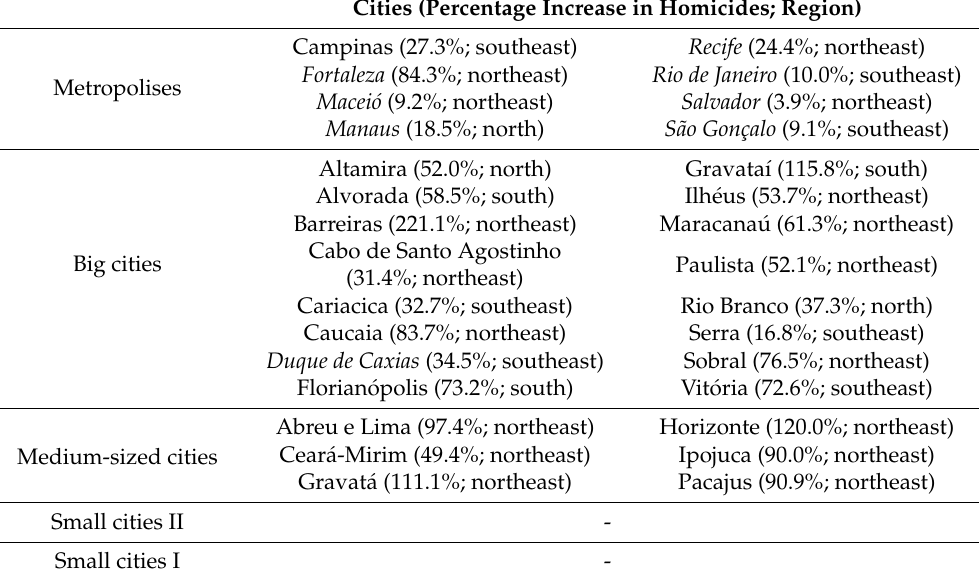
Table 5. Cities in Brazil that accounted for the equivalent national increase in homicides between 2016 and